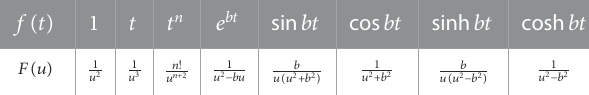
TABLE 1 Aboodh transform of some elementary